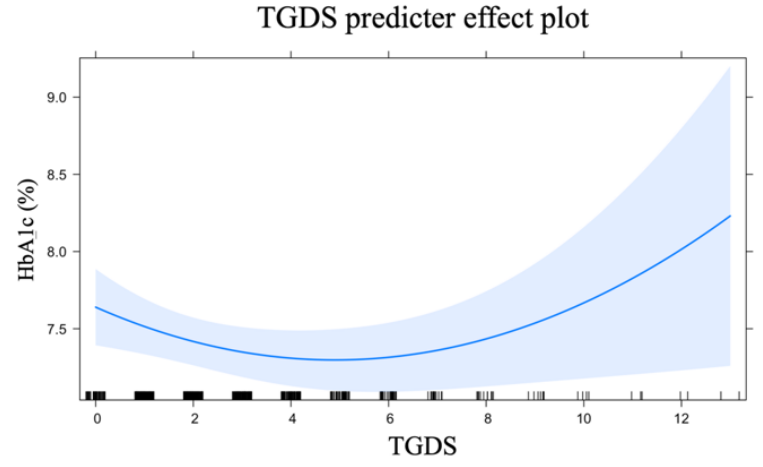
Figure 4. The predictor effect plots of TGDS as a predictor to glycemic control.